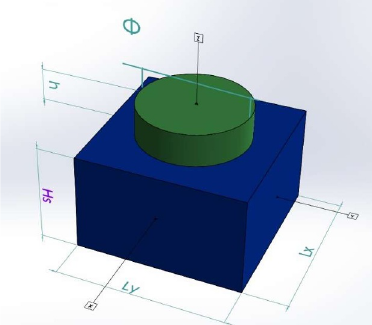
Fig 1. The elementary cell through which can be obtained a metasurfaces of variable dimensions by translation in the two directions x and y . The propagation direction of the electromagnetic radiation is the z direction.